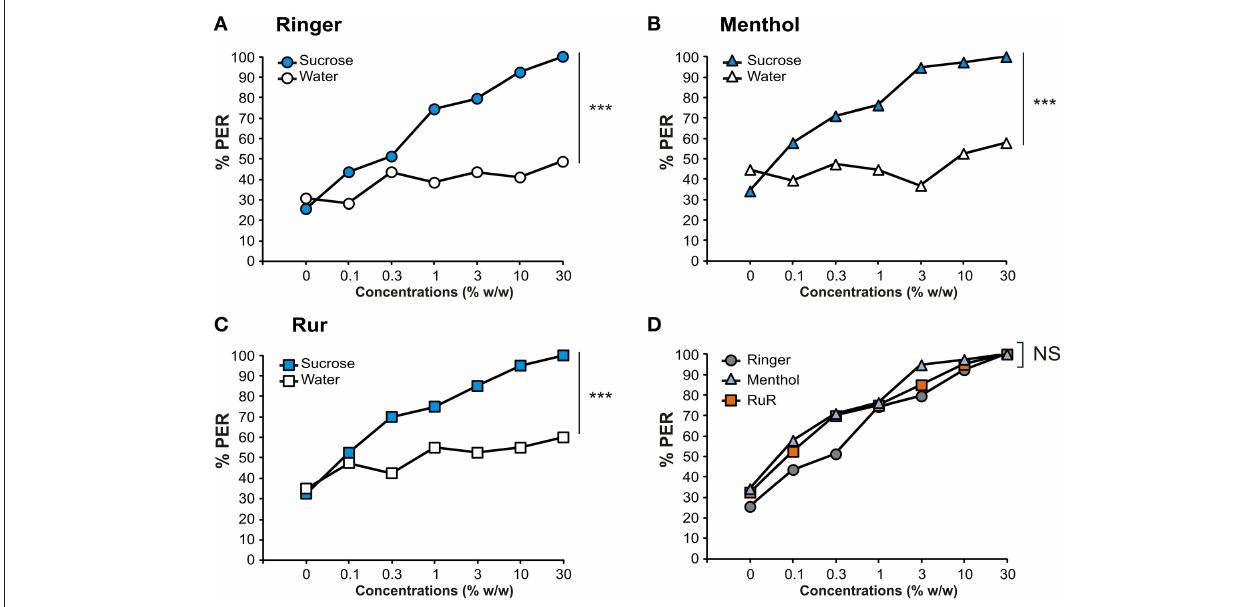
FIGURE 8 | Effect of HsTRPA inhibitors on sucrose responsiveness. Different groups of bees were injected with Ringer as control (A) or with a HsTRPA inhibitor, either (B) menthol (5mM) or (C) Ruthenium red (RuR, 1mM). Proboscis extension responses (PER) were measured in response to sucrose solutions at increasing concentrations (blue) alternated with water controls (white). (D) Comparison of sucrose response curves among the three groups (Ringer: gray circles; menthol: light blue triangles; RuR: orange squares). Inhibitor injections did not impact sucrose responsiveness (NS: Non Significant; *** p < 0.001